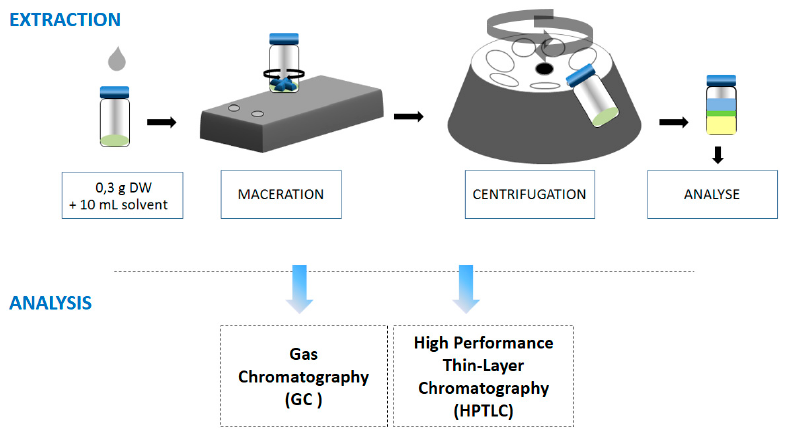
Figure 6. Global procedure; extractions and analysis of lipids from Yarrowia lipolytica .